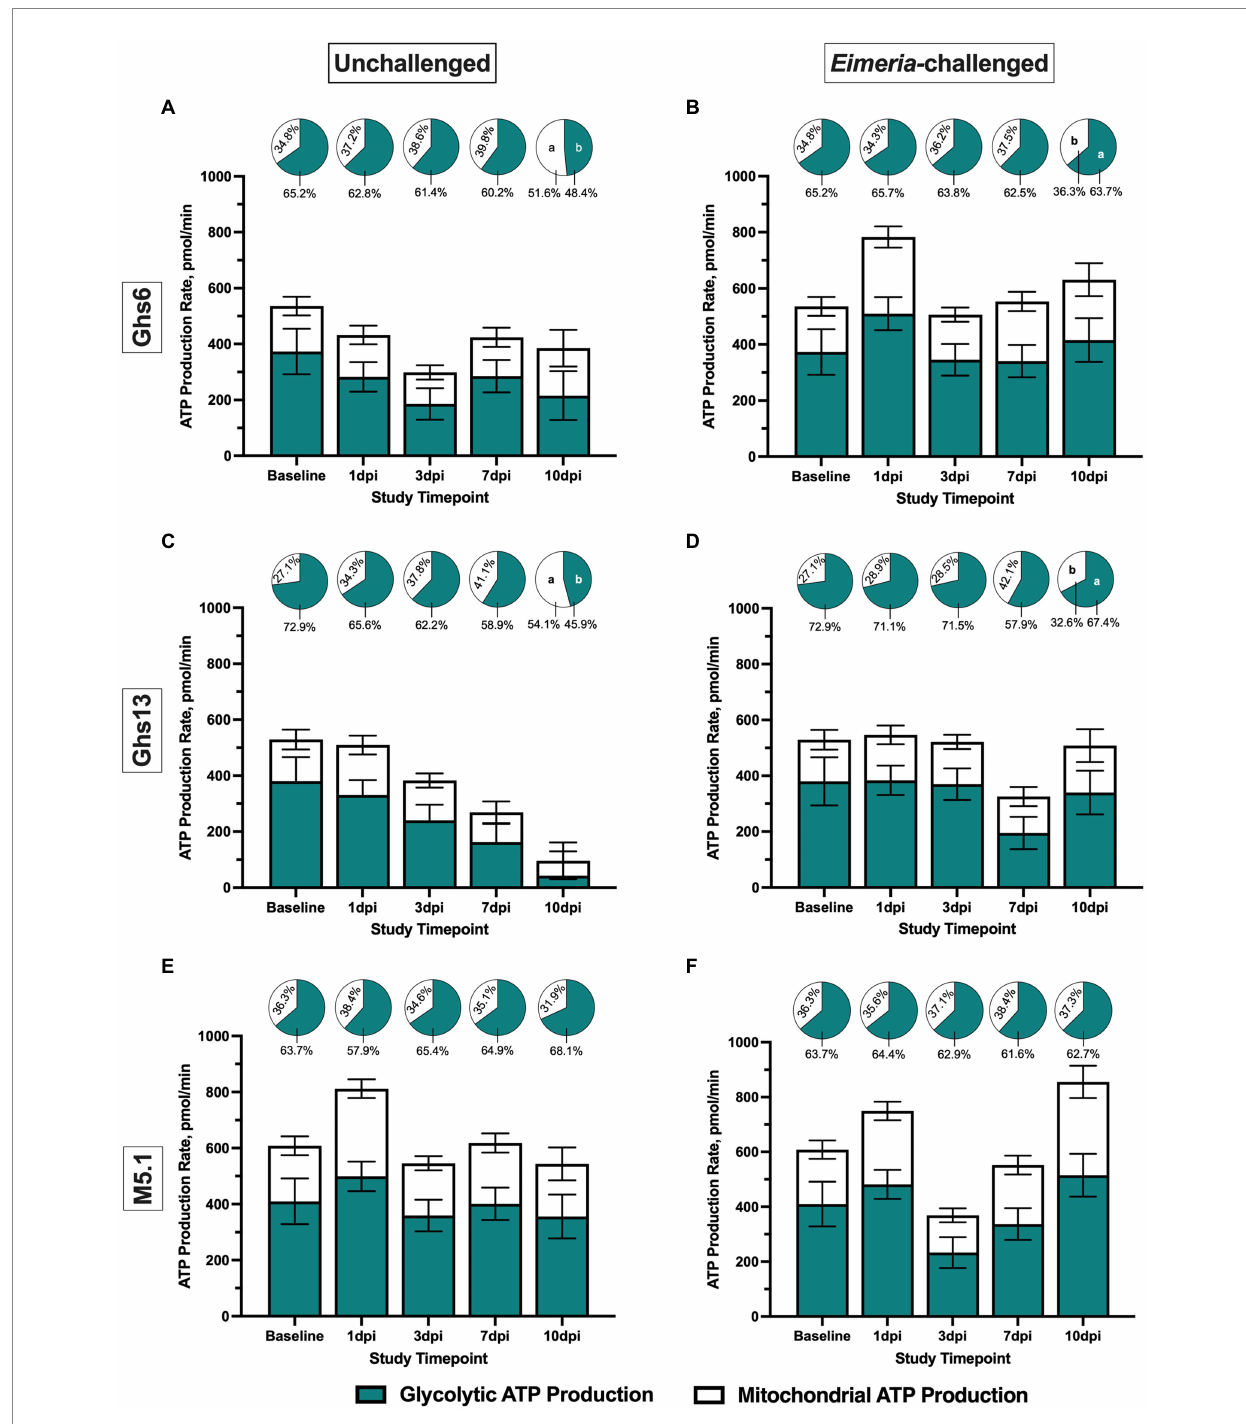
FIGURE 1 Peripheral blood mononuclear cell ATP production (200,000 cells/well) among Leghorn (A,B) Ghs6 and (C,D) Ghs13 and (E,F) Fayoumi M5.1 inbred genetic lines before and after inoculation with 10X Coccivac-B52 (Merck Animal Health, Kenilworth, NJ) as determined by the Agilent Real-Time ATP Rate Assay and Seahorse XFe96 analyzer (Santa Clara, CA). Data represent mean ATP production rate (pmol/min) attributed to glycolytic and mitochondrial metabolism ( n = 5 birds/treatment) ± SEM. Filled and empty bars denote separate ATP contributions from glycolytic and mitochondrial metabolism, respectively, while the stacked bar (filed + empty) represents total ATP production. Pie charts above each bar denote the relative contribution of each pathway as a percentage of total ATP production. Different letter labels on same-colored slices within the same timepoint are significantly different, p ≤